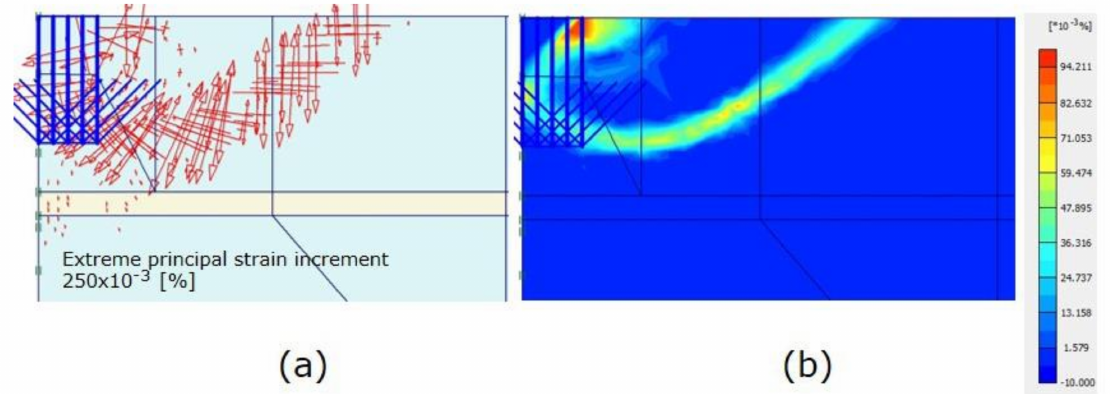
Figure 8. Incremental strains at failure for the case in which the sand has ϕ (cid:48) 1 = 40 ◦ and ψ (cid:48) 1 = 40, while the weak layer is characterised by ϕ (cid:48) 2 = 35 ◦ and ψ (cid:48) 2 = 35; the depth of the weak layer is z i /B = 1.5. ( a ) principal directions; ( b ) shear